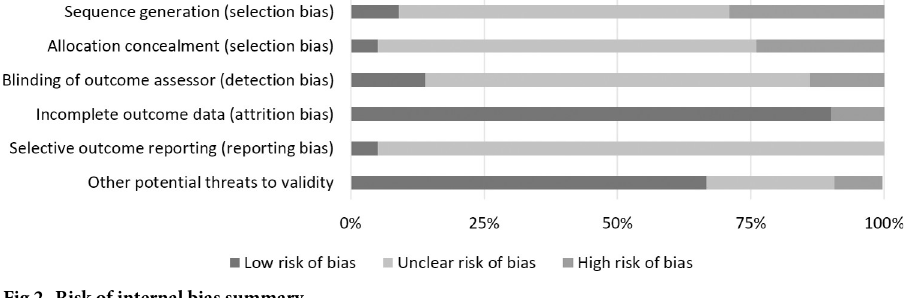
Fig 2. Risk of internal bias